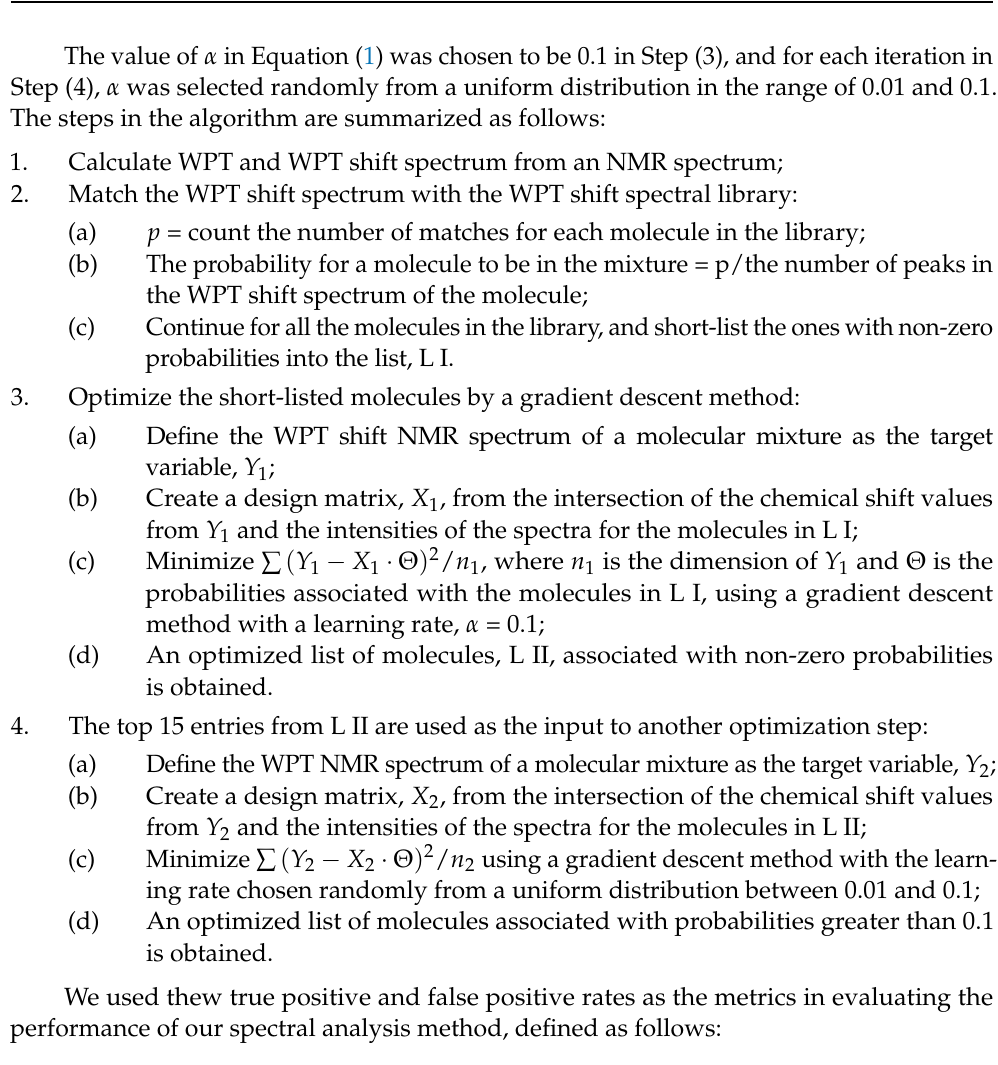
Design Matrix, X Molecule